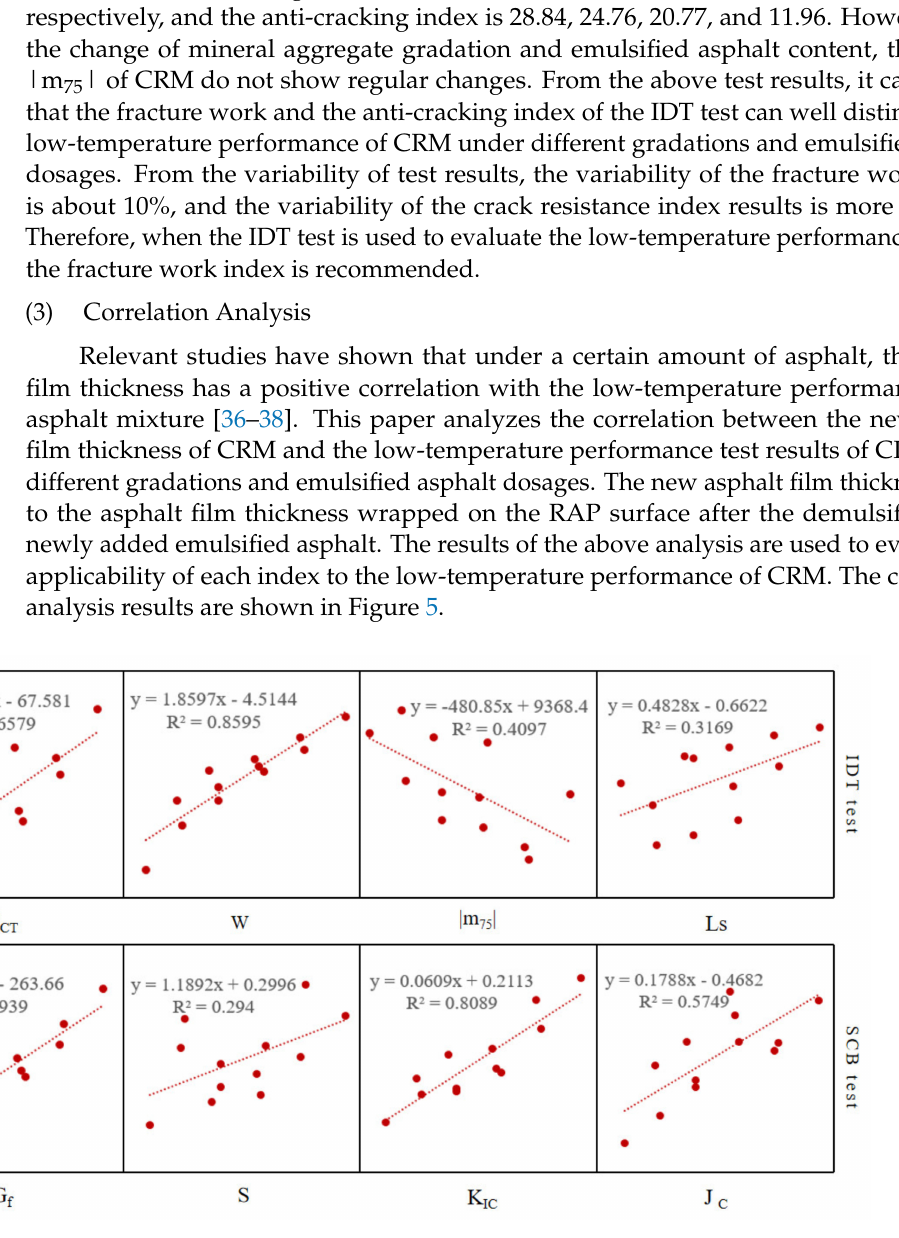
Figure 5. Correlation analysis between new asphalt film thickness and low-temperature crack resistance